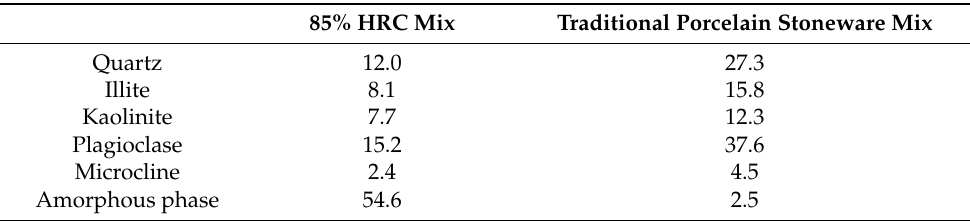
Table 2. Mineralogical compositions (wt%) of the unfired powders of the 85% HRC mix and tradi- tional porcelain stoneware